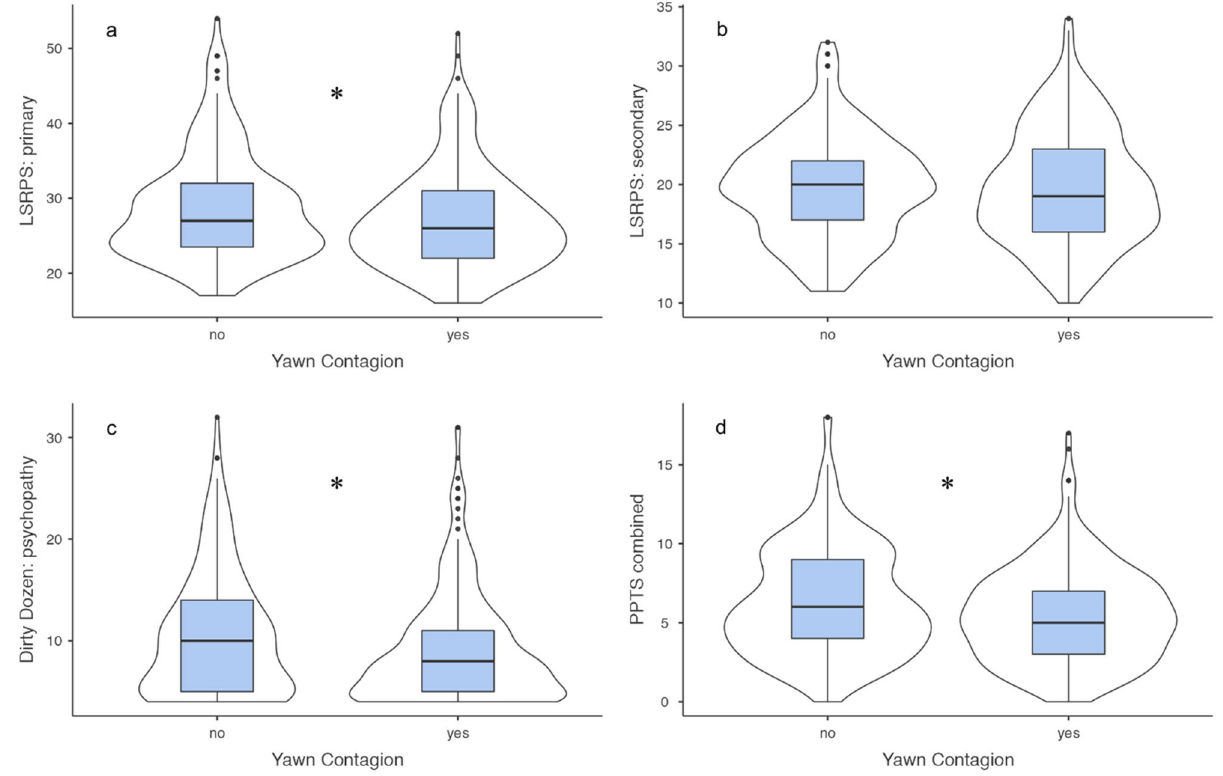
Figure 2. Box and violin plots depicting the relationship between psychopathic trait scores and contagious yawning. Participants that yawned contagiously scored significantly lower (* p < 0.05) on (a) the primary psychopathy scale of the LSRPS, (c) the psychopathy construct of the Dirty Dozen , and (d) the combined PPTS. There was no difference between yawners and non-yawners on (b) the secondary psychopathy scale of the LSRPS. Box plots represent the median, interquartile ranges, and the whiskers extend 1.5 times the interquartile range for the upper and lower boundary, while the violin plots illustrate the distribution of the psychopathy trait